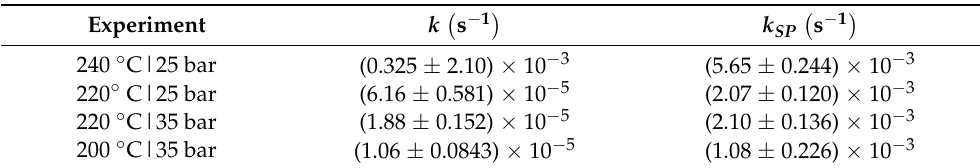
Table 7. Estimated kinetic parameters and their uncertainty for a 97.5% confidence interval for Model 2.